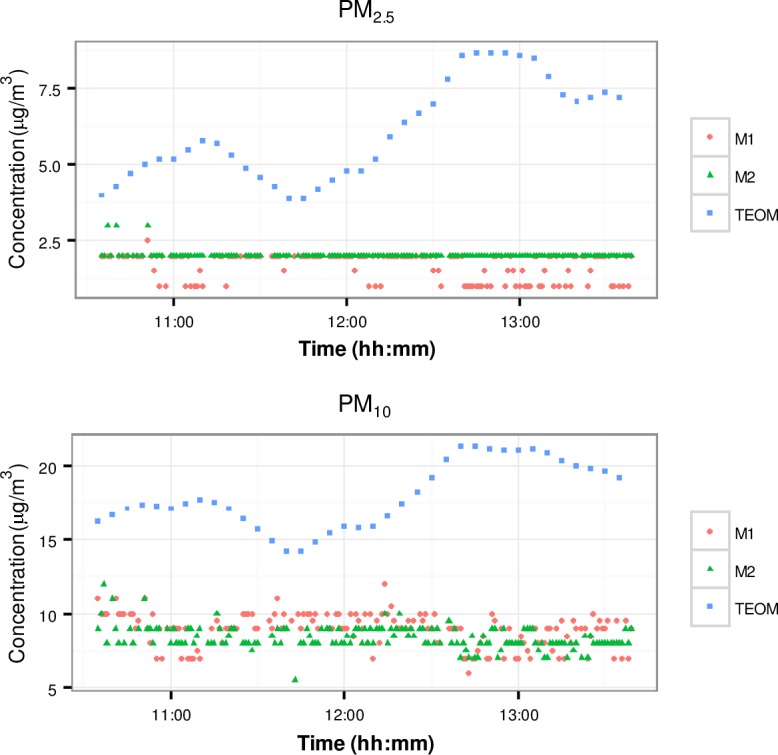
Time series of mass concentrations at the Rocklea station measured by the phones and the TEOM.